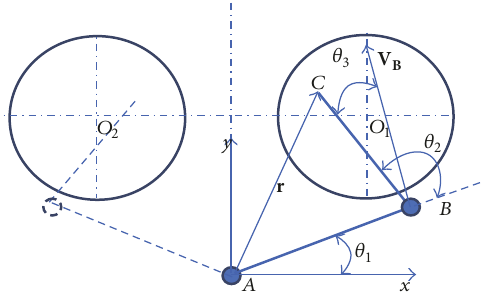
Figure 5: Schematic diagram of the robot (vertical view).